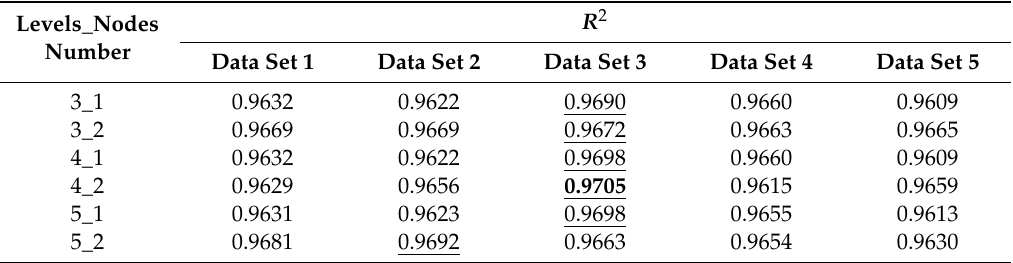
Table 4. Validation analysis for FCM clustering.